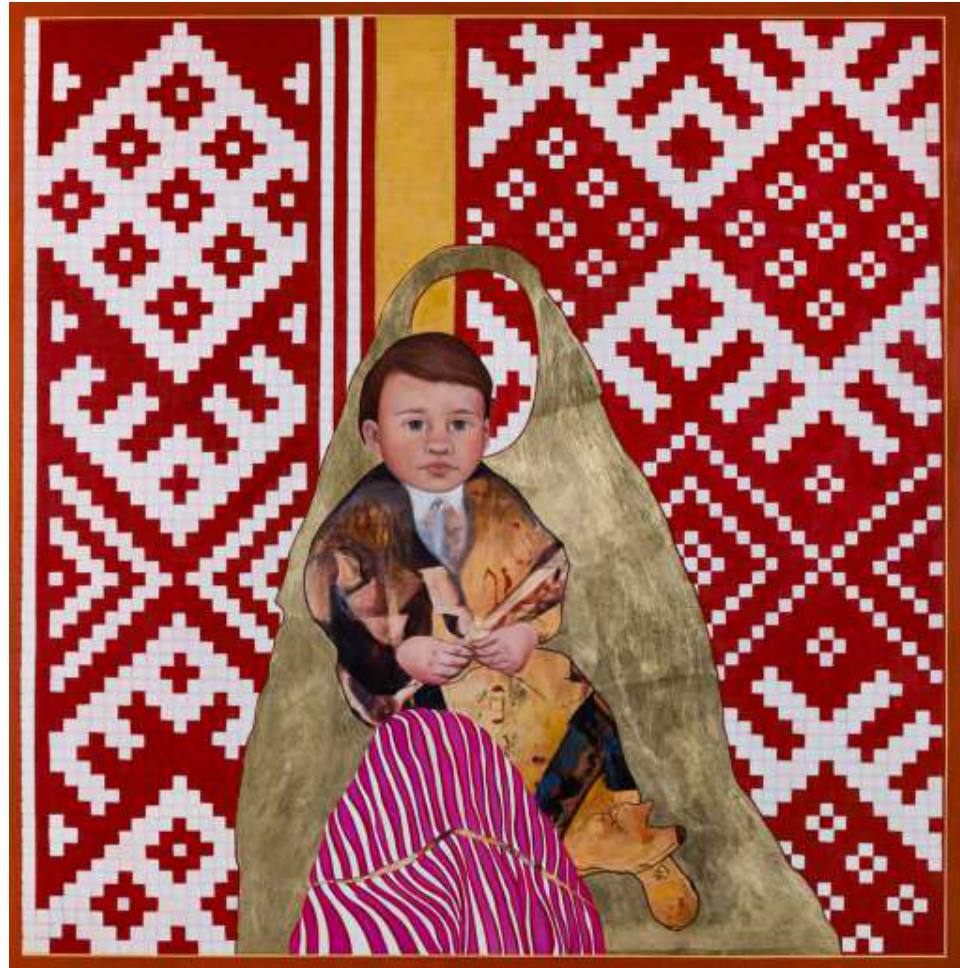
Julia Lambright, Tetris , 2013, egg tempera, oil, and gold leaf on panel, 36.5 x 36 x 0.5